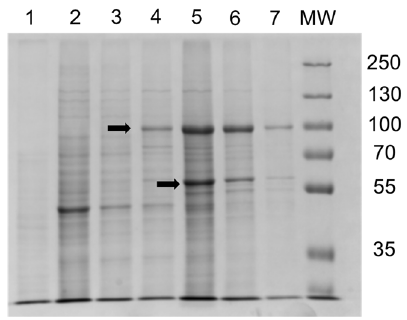
Figure 6. SDS-PAGE analysis of Ni-NTA agarose elution profile for CnCPR-6×His co-expressed with CnCYP51-6×His. Lane 1: 10 μ L of the flow through after the DM solubilised plasma membrane frac- CnCYP51-6 × His. Lane 1: 10 µ L of the flow through after the DM solubilised plasma membrane tion was incubated overnight with the agarose beads. Lanes 2 and 3: 5 μ L of the 1 mM histidine fraction was incubated overnight with the agarose beads. Lanes 2 and 3: 5 µ L of the 1 mM histidine washes of the proteins bound agarose beads. Lanes 4–7: 5 μ L of the proteins eluted using 200 mM washes of the proteins bound agarose beads. Lanes 4–7: 5 µ L of the proteins eluted using 200 mM imidazole. MW: 5 μ L protein molecular weight markers (PageRuler Plus pre-stained protein ladder, imidazole. MW: 5 µ L protein molecular weight markers (PageRuler Plus pre-stained protein Thermo Scientific). The arrow at 90 kDa indicates the putative CnCPR-6×His (82 kDa size) and the arrow at 62 kDa indicates the putative CnCYP51-6×His.